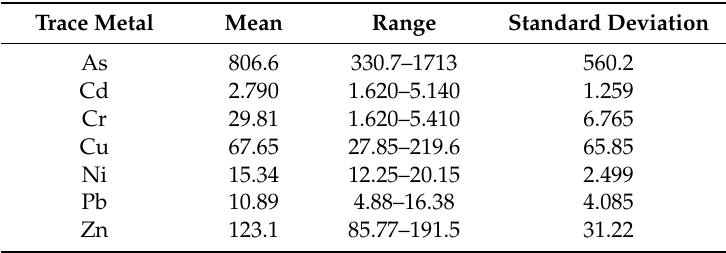
Table 5. Summary of trace metal concentrations in alluvial units defined at RL1; values given in mg /